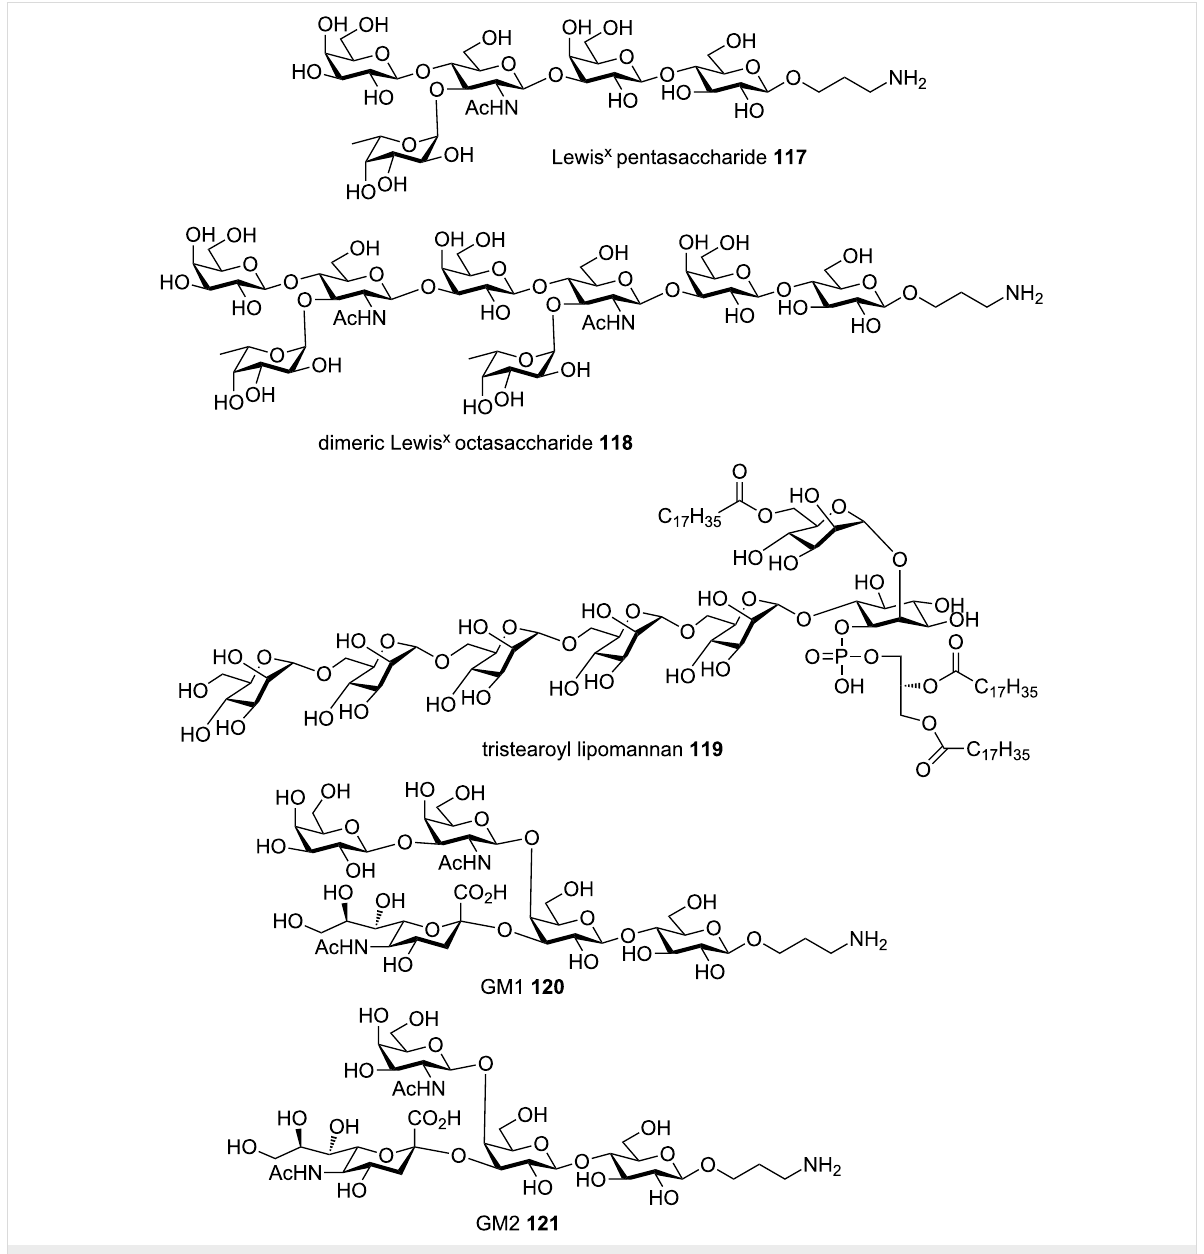
Figure 5: Representative complex glycans from glycolipid family synthesized by the preactivation-based thioglycoside method.